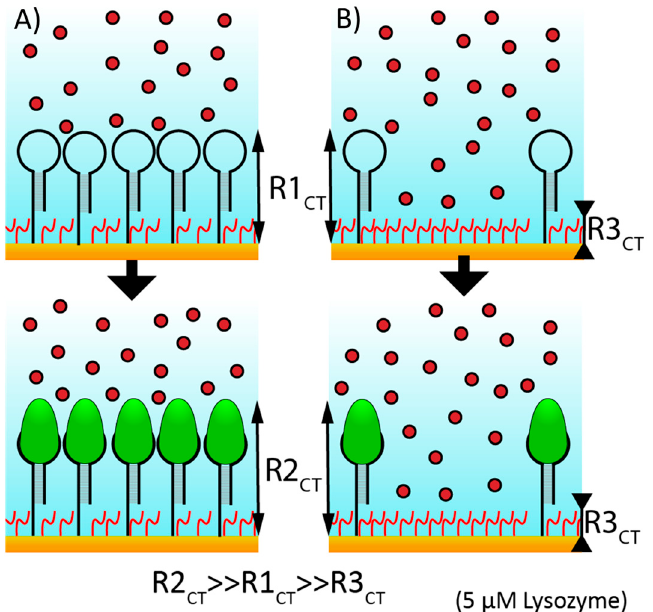
Figure 1. Schematic of electrochemical impedance spectroscopy (EIS) sensing using lysozyme aptamer (loop) and lysozyme antigen (green oval, bottom panel) demonstrates why in this instance only high density self-assembled monolayers (SAMs) ( A ) and not low density SAMs ( B ) are expected to have substantial changes in R CT , as they occlude ferricyanide redox reporters (red circles) from the surface.